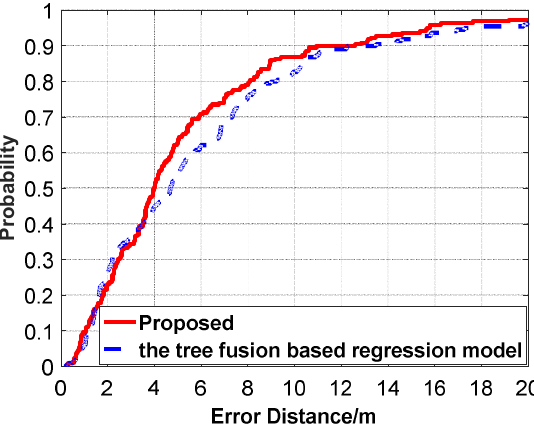
Figure 21. Comparison of CDF positioning errors between the proposed algorithm and the tree-fusion-based regression model. Table 4. Average positioning errors of the proposed algorithm and the tree-fusion-based regression model.